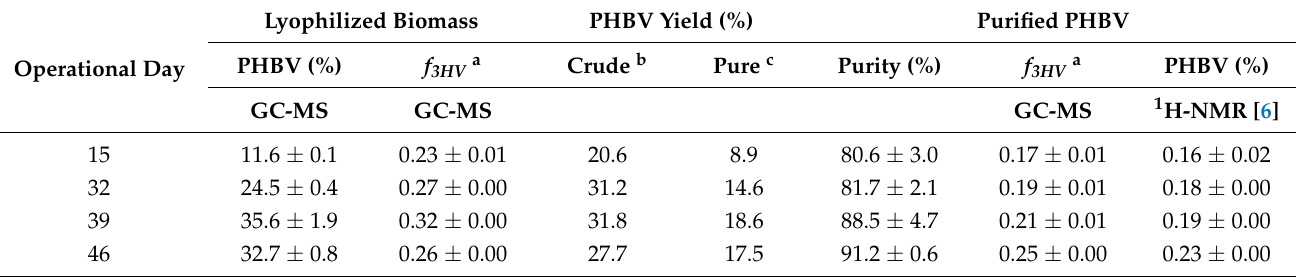
Table 1. PHBV and 3HV content in biomass, crude and purified PHBV yields and 3HV content in purified